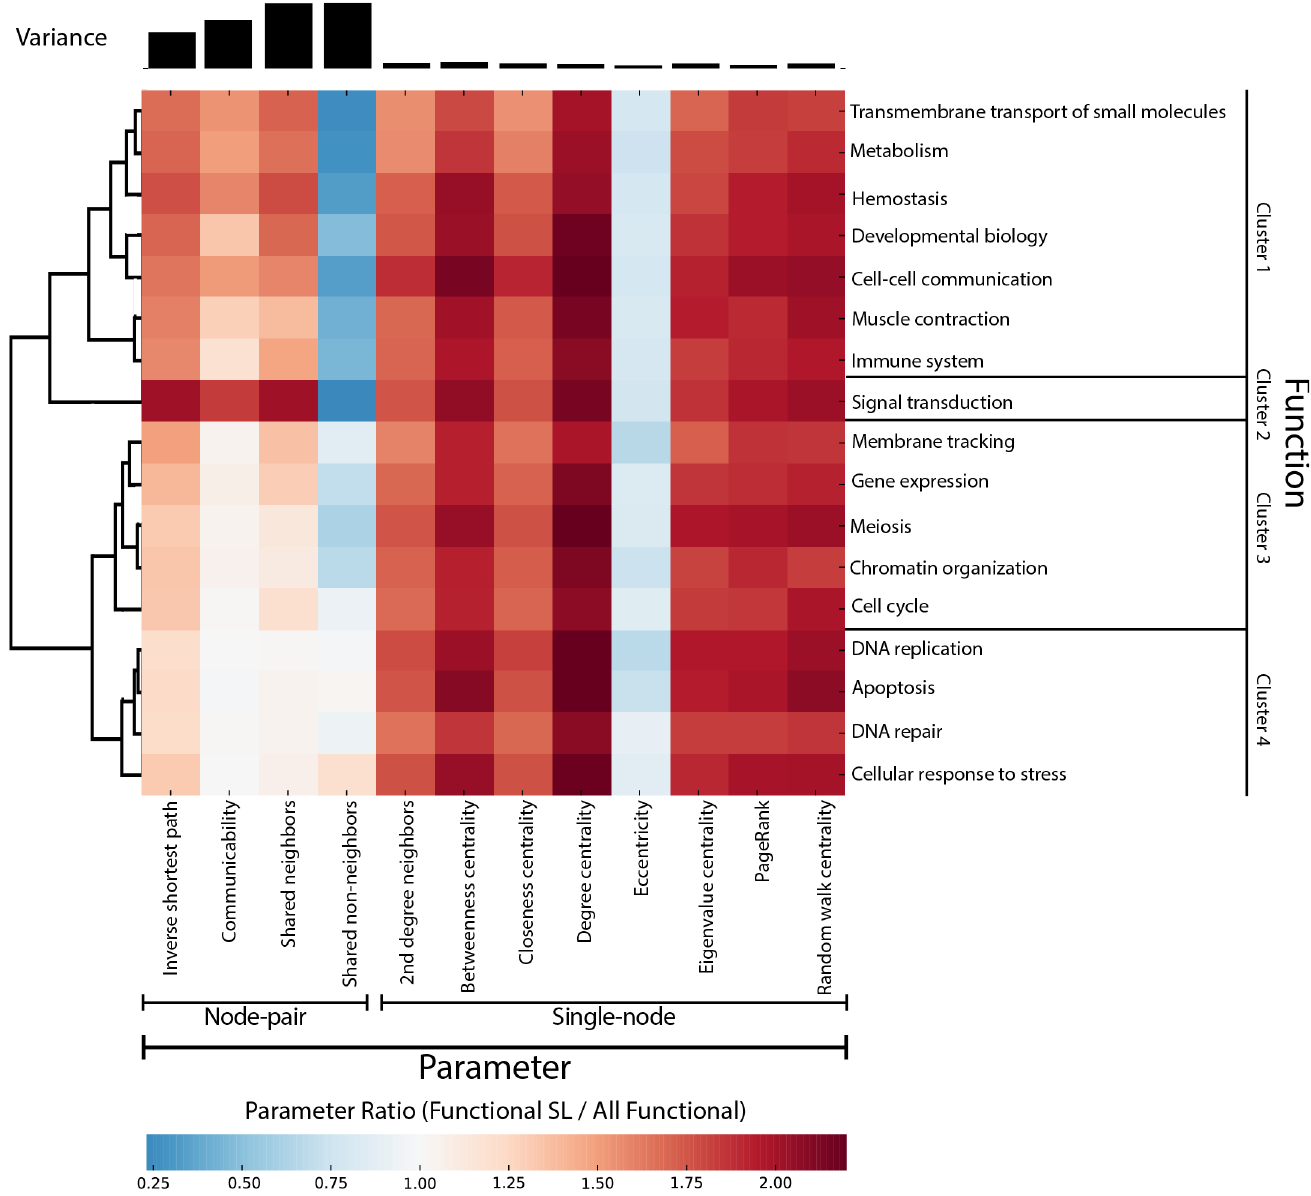
Fig 5. Function-specific patterns of synthetic lethality. The heatmap represents the ratio of median parameters for the SL pairs of a given function versus all pairs of a given function. For example, the SL pairs of Signal Transduction have two-times greater values for inverse shortest path than for the non-SL pairs of Signal Transduction. Rows are clustered by node-pair parameter values (see Table 1). Parameter variance is plotted above the heat map. Single- node parameters (see Table 1) are consistently altered in SL regardless of function. However, node-pair parameters differ between functions. This distinction suggests that network substructure may dictate SL mechanisms associated with a specific